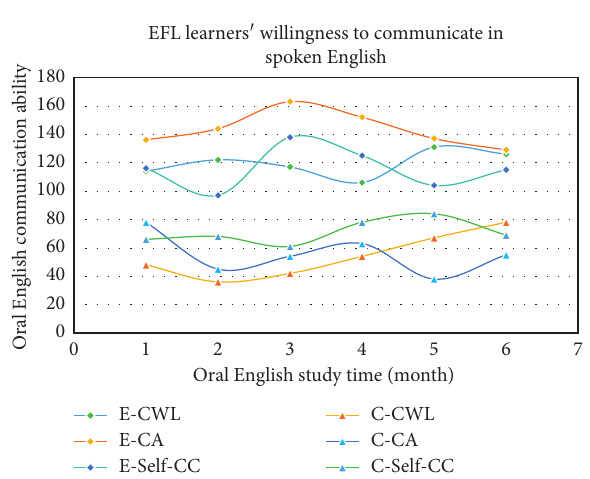
Figure 5: EFL learners’ willingness to communicate in spoken